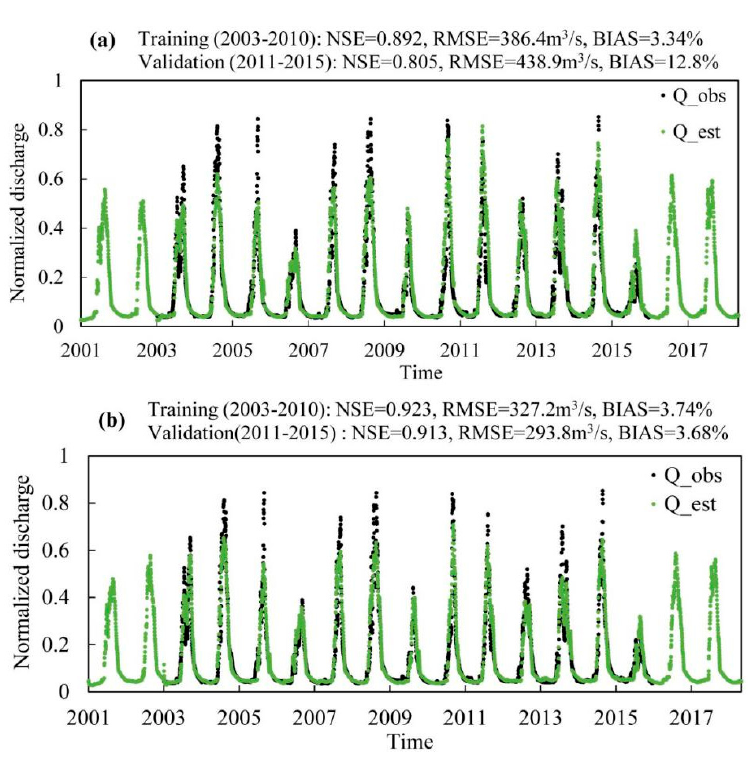
Figure 8. Normalized daily discharge estimates ( a ) using segmented TRMM precipitation data at Yangcun station and ( b ) using segmented CMFD precipitation data at Yangcun station.